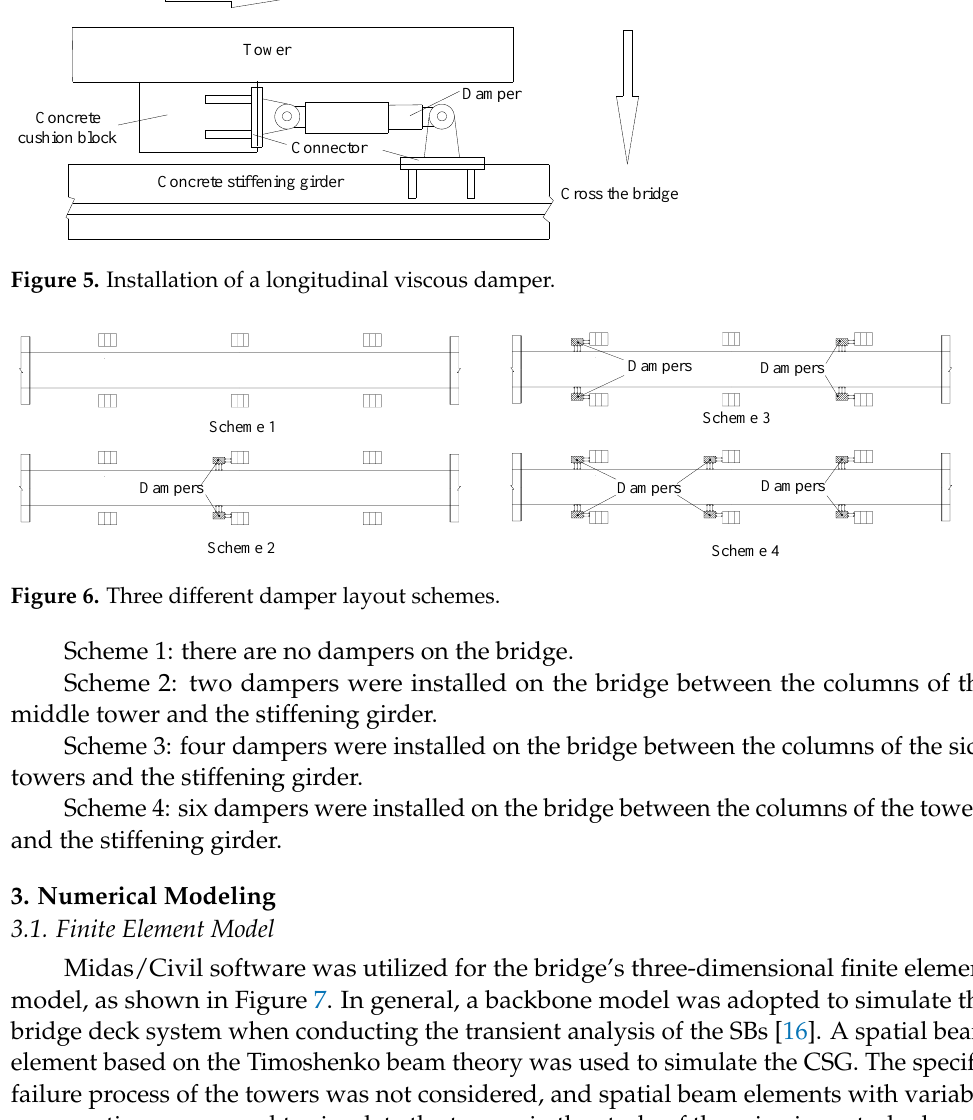
Figure 7. Finite element model.